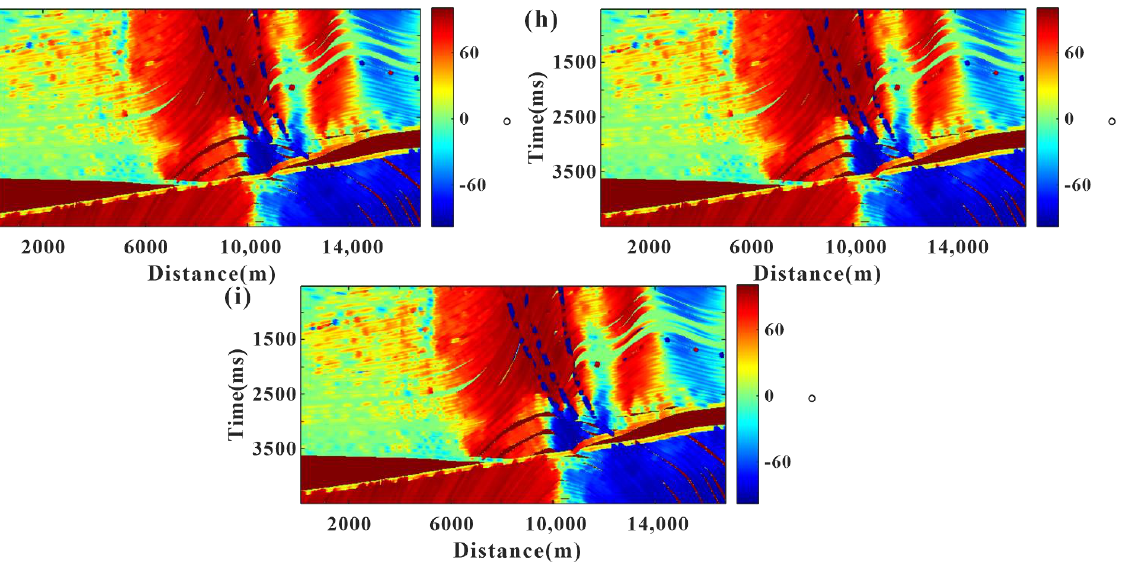
Figure 11. Estimation results of autocorrelation parameters directly from the model: ( a – c ) are the horizontal autocorrelation length of porosity, clay volume, and water saturation, respectively. ( d – f ) are the vertical autocorrelation length of porosity, clay volume, and water saturation, respectively.